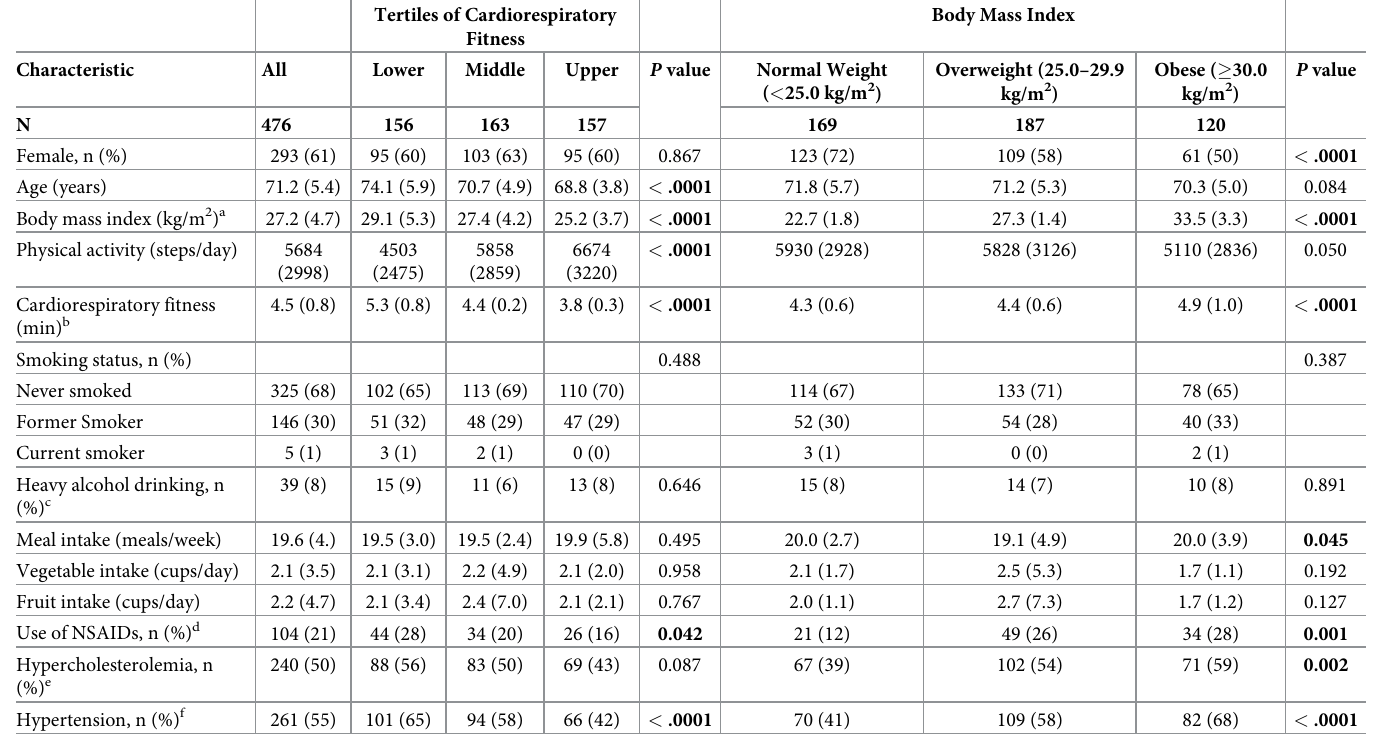
Table 1. Baseline characteristics by cardiorespiratory fitness and body mass index categories. Tertiles of Cardiorespiratory